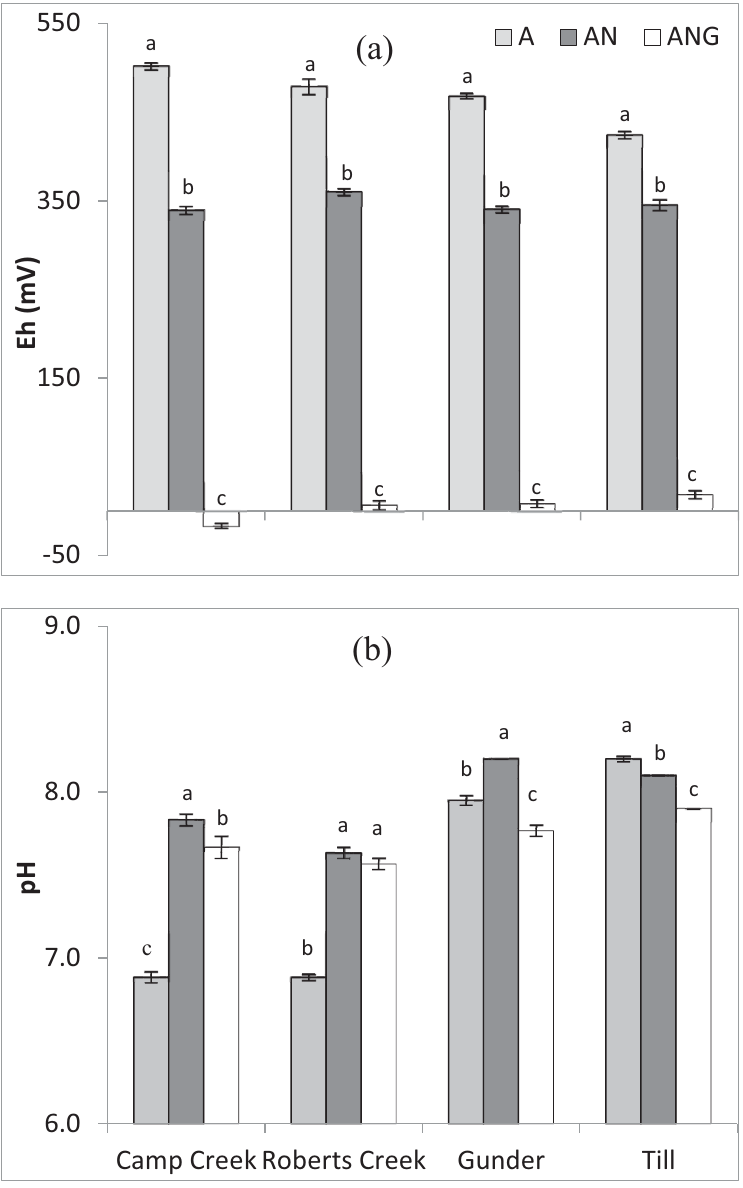
Fig 4. Effects of the treatments (A = without anaerobic incubation, AN = with anaerobic incubation, and ANG = with anaerobic incubation + glucose) on redox potential (Eh) (a) and pH (b) at 24 hours for Treatment A and at 30 days for Treatments AN and ANG. Means with different letters within the same sediment are significantly different (least significant difference test at α = 0.05). Error bars represent standard error.